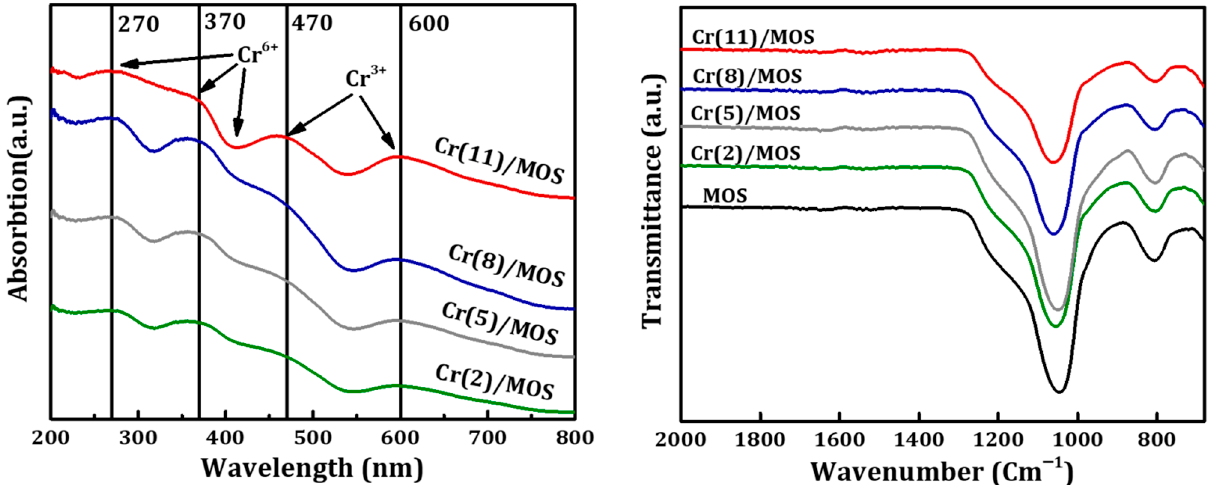
Figure 5. UV–Vis DR spectrum ( A ) and FTIR patterns ( B ) of Cr(x)/MOS catalysts prepared with varying Cr